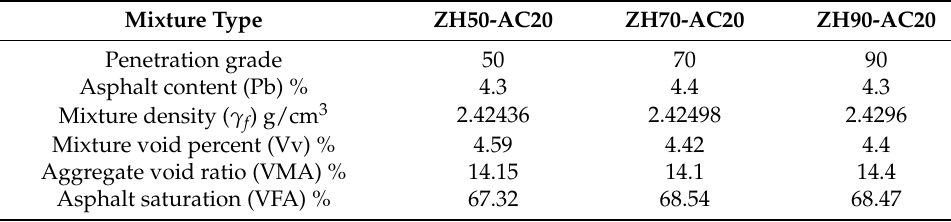
Table 1. Asphalt and asphalt mixture indexes.